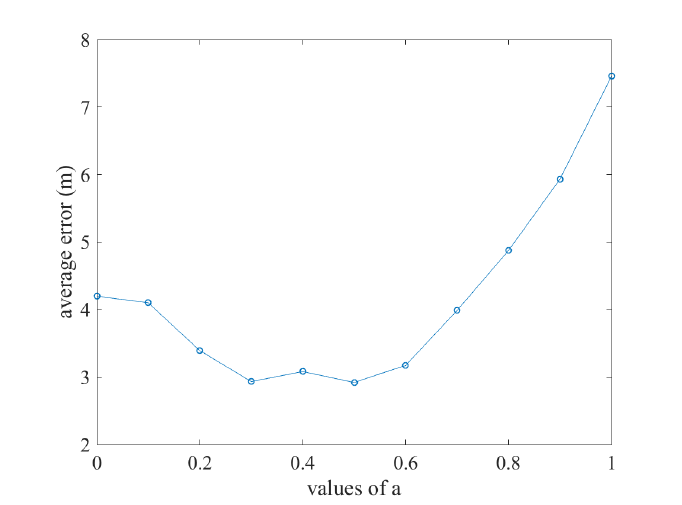
Figure 4. Average positioning error over different values of hyper-parameter a